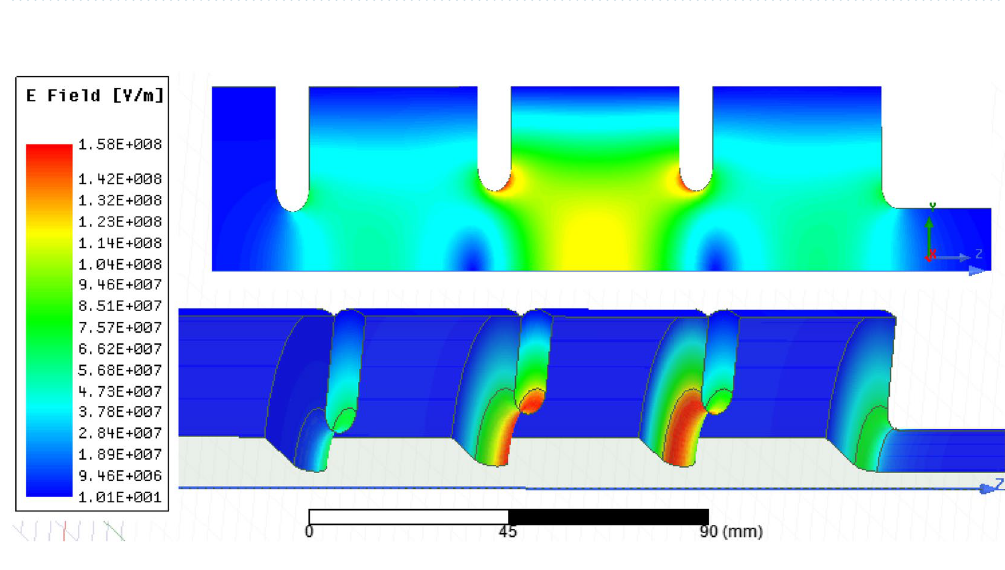
Figure 6. Electric field for 8 MW input power.